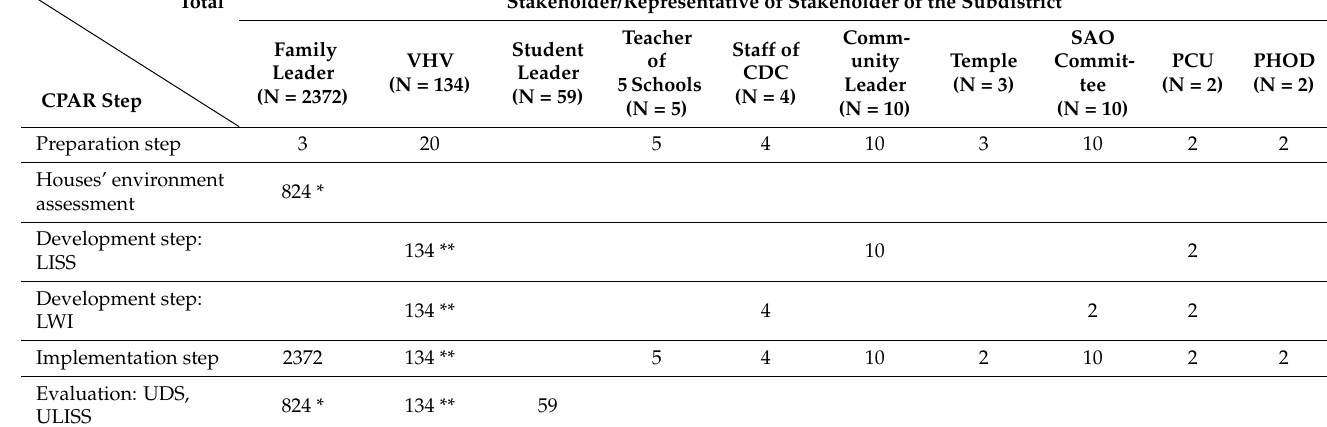
Table 1. Stakeholders and Representative of Stakeholder in the community participatory action research